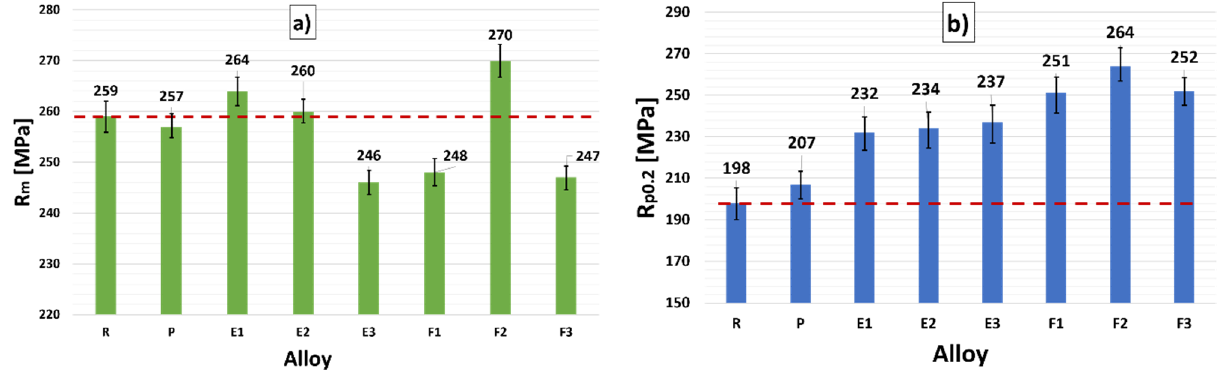
Figure 12. Dependence of ( a ) R m and ( b ) R p0.2 after heat treatment for R, P, and experimental alloys E1–E3 and F1–F3.